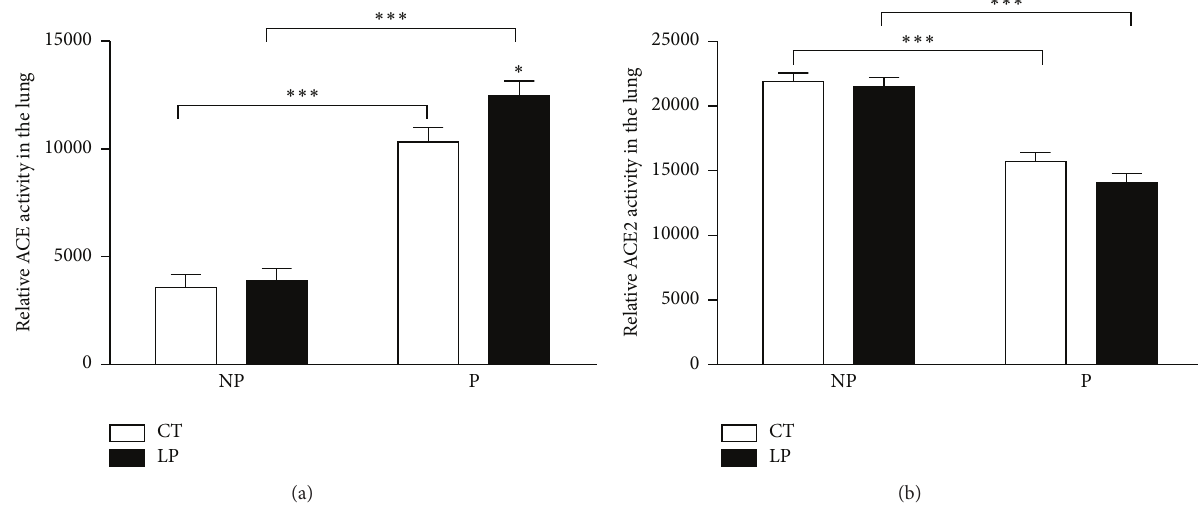
Figure 9: Relative activities of ACE (a) and ACE2 (b) in the lung of nonpregnant and pregnant rats fed the low-protein diet. CT: control; LP: low protein; NP: nonpregnant rats fed either CT or LP diet for 17 days; P: pregnant rats fed either CT or LP diet for 17 days. The error bar represents the mean ± SEM ( 𝑛 = 5 - 6 rats/diet group/day). ∗ 𝑃 < 0.05 ; ∗∗∗ 𝑃 < 0.001